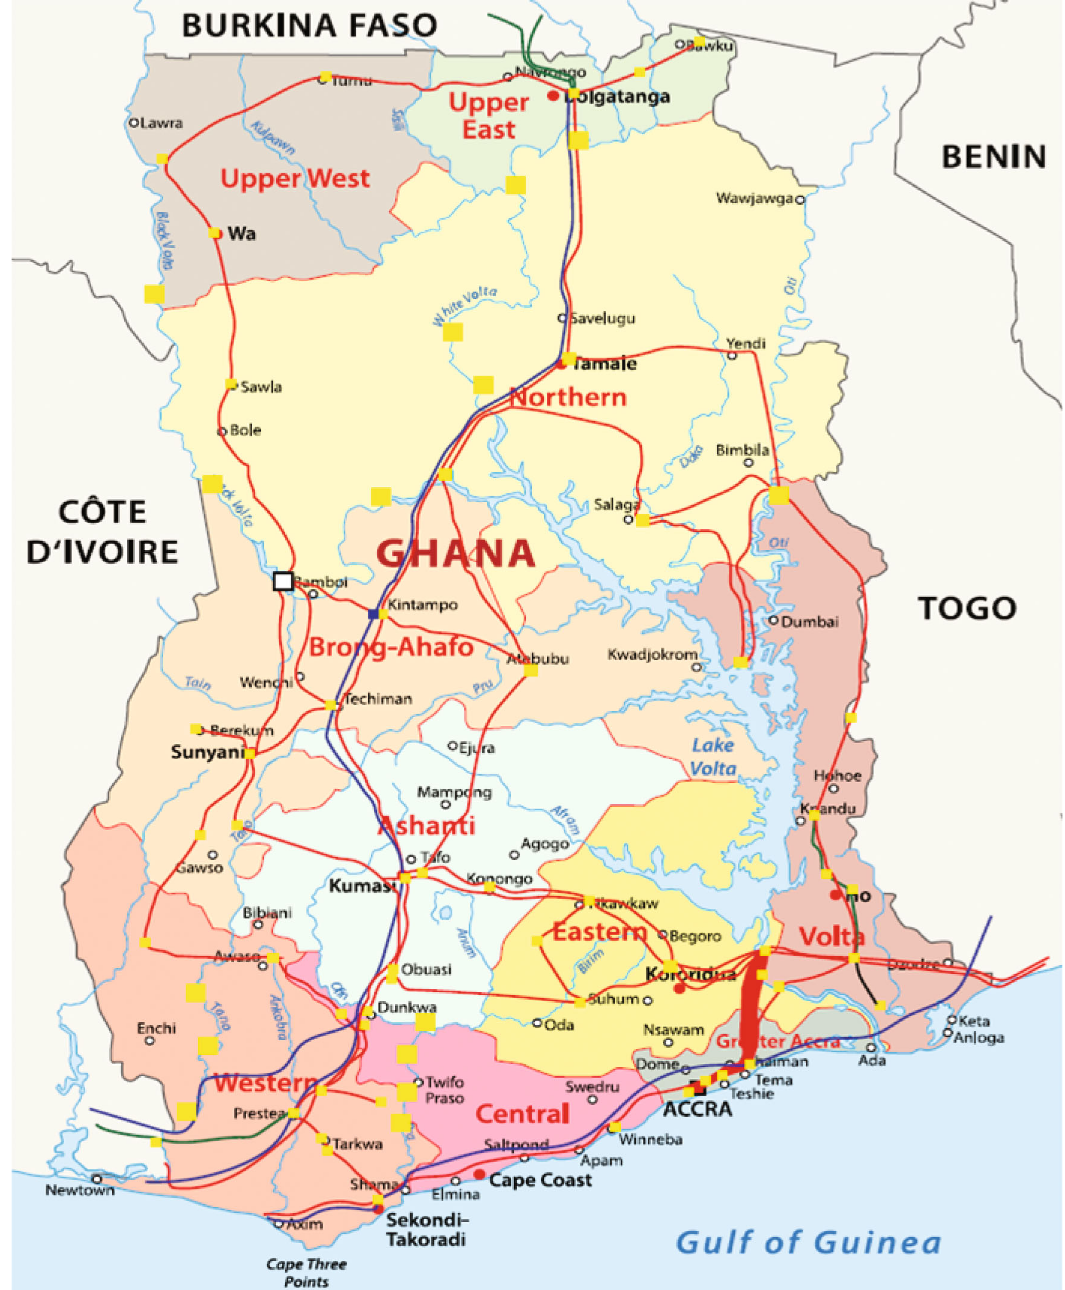
Figure 1: Ghana ’ s national interconnected system